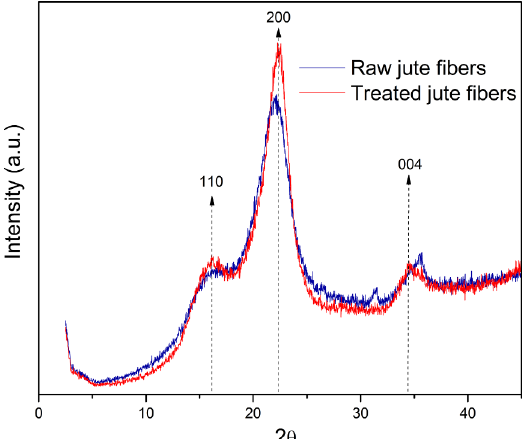
Figure 1. X-ray diffraction curves of raw and treated jute fibers.